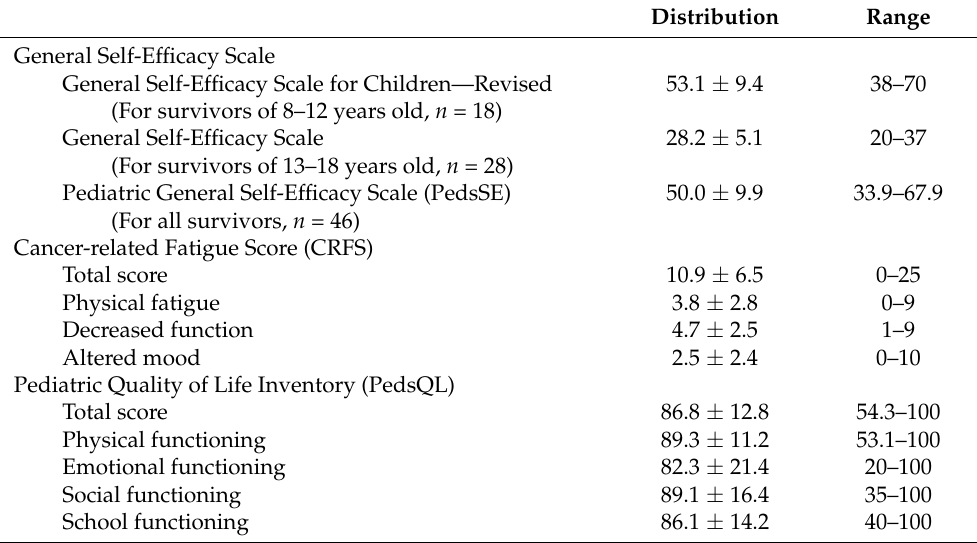
Table 2. Distributions of measures on self-efficacy, cancer-related fatigue, and health-related quality of life in childhood cancer survivors ( n =